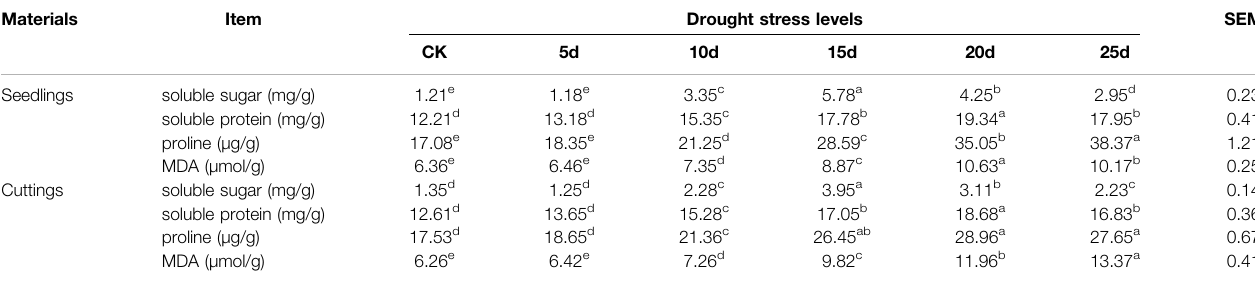
TABLE 2 | Effect of drought stress on physiological indicators in seedlings and cuttings of tea plant. Materials Item